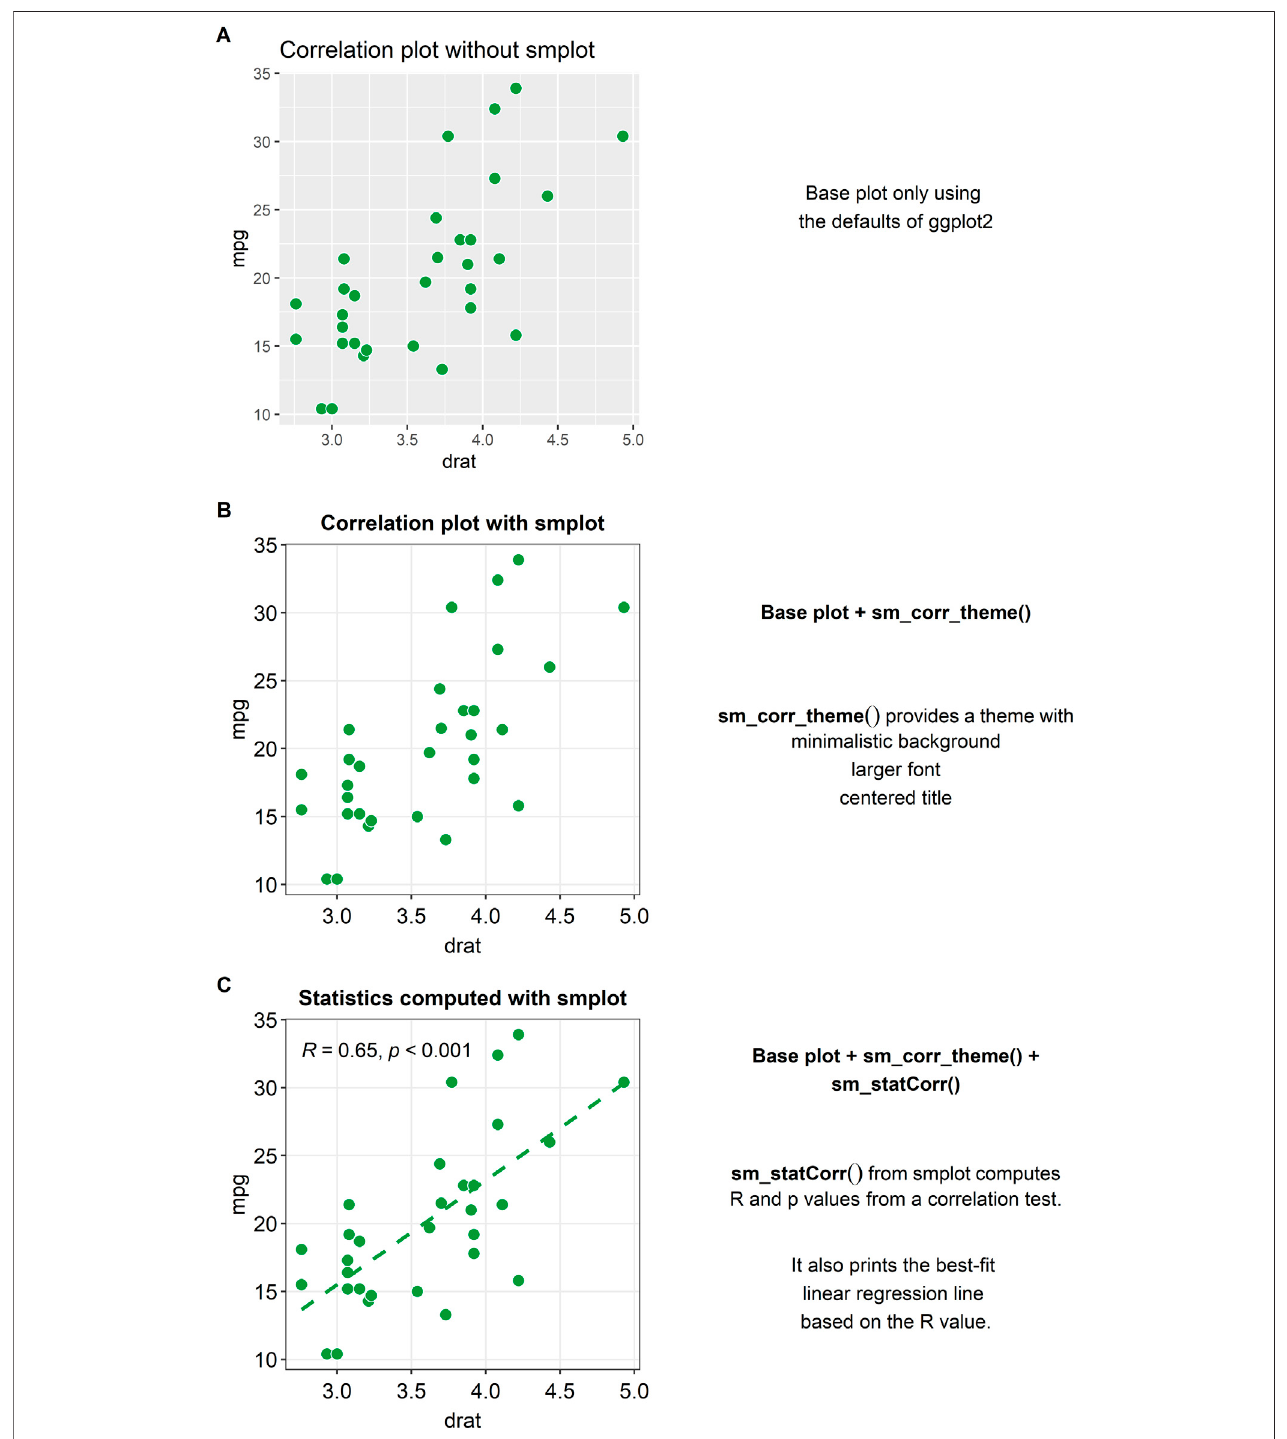
FIGURE 1 | Correlation plots with and without smplot . (A) A correlation plot without using smplot . (B) A correlation plot with a default theme of smplot . The theme can added in a modular fashion by adding “ sm_corr_theme() ” to the base plot. This function provides a theme with a minimalistic background, a larger font and a centered title. (C) A correlation plot with the default theme of smplot , printed statistical information ( R (cid:1) correlation coef fi cient, p (cid:1) statistical signi fi cance) and a best- fi t regression line. The R and p values as well as the regression line can be printed by adding the “ sm_statCorr() ” to the given plot in a modular fashion.